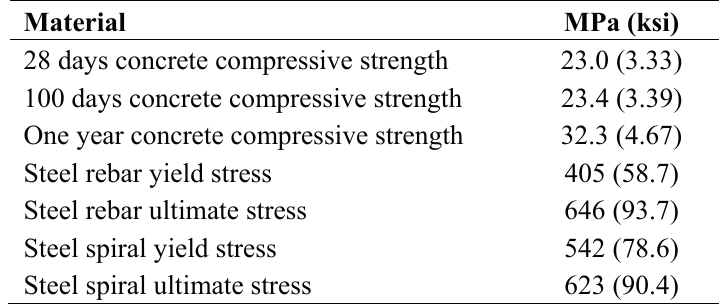
Table 1. Mechanical properties of concrete and steel